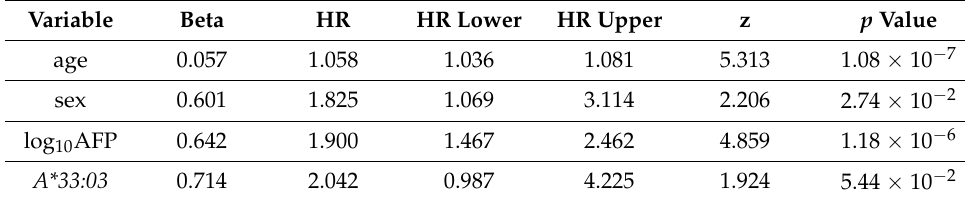
Table 2. Cox proportional hazards model with four associated variables.